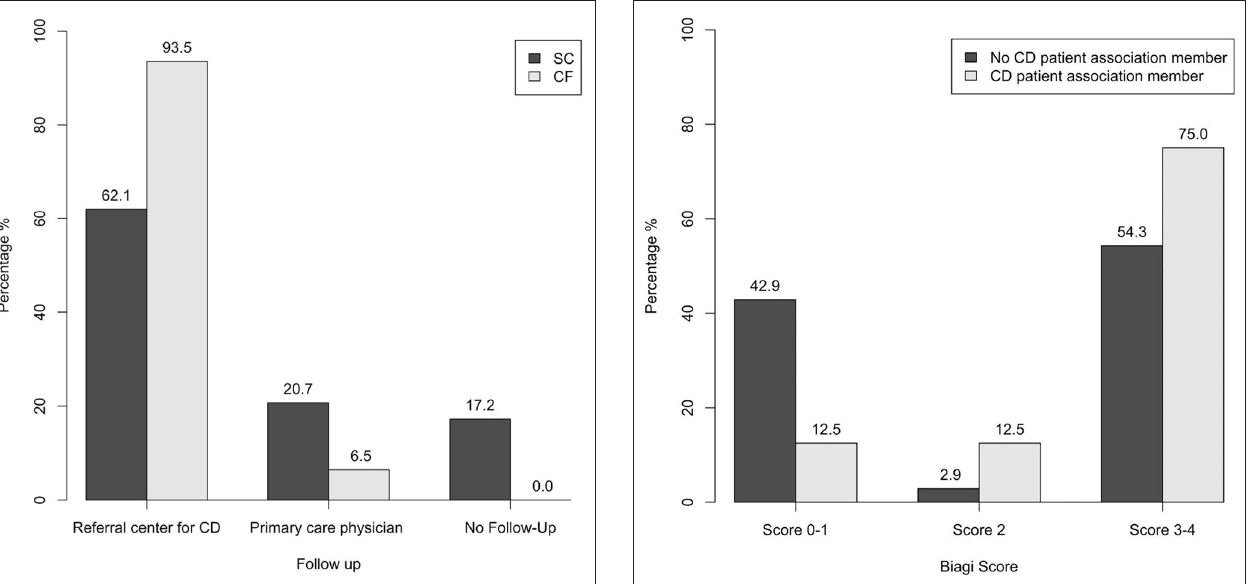
FIGURE 6 | Association between CD patient association membership and dietary compliance assessed through the Biagi score in the 60 patients enrolled ( p = 0.027). CD, celiac